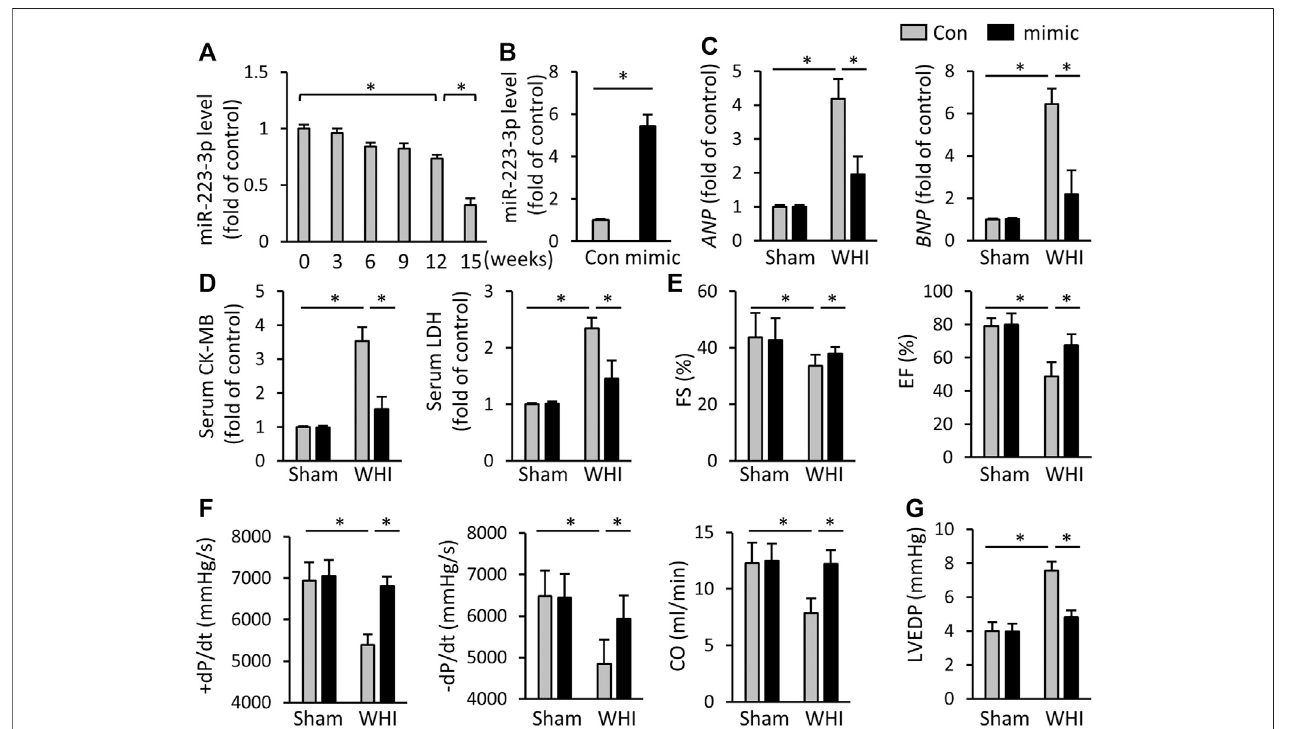
FIGURE1| miR-223-3pmimicattenuatescardiacinjuryanddysfunction. (A) RelativelevelofmiR-223-3pincardiacwith20 GyWHIweredetectedattheindicated times ( n (cid:2) 6). (B) Relative level of miR-223-3p in mice hearts with or without miR-223-3p mimic treatment ( n (cid:2) 5). (C) Relative mRNA levels of ANP and BNP in the hearts ( n (cid:2) 6). (D) Serum biomarkers related to cardiac injury with or without miR-30d-5p mimic treatment upon WHI stimulation, including CK-MB and LDH ( n (cid:2) 6). (E – G) Echocardiographic and hemodynamic parameters were detected at 16 weeks after WHI or sham therapy ( n (cid:2) 6). CO, cardiac output; All data are presented as means ± SD. * p < 0.05 vs. the matched